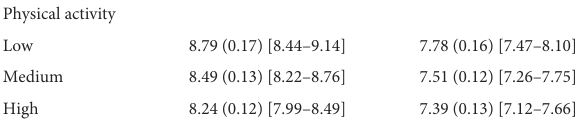
TABLE 4 Estimated means of SDQ-Total at Wave 1 in different levels of PA at baseline. Boys